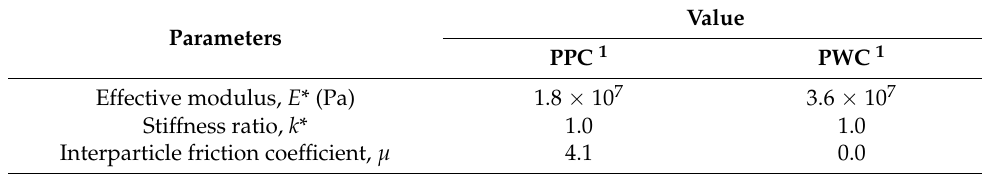
Table 1. Micro-mechanical parameters for fresh ballast assembly.